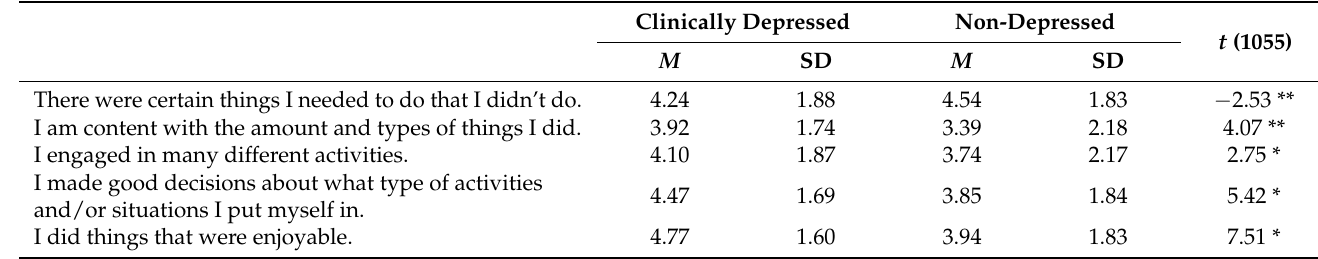
Table 1. Depression mitigation scores by clinical diagnosis. Clinically